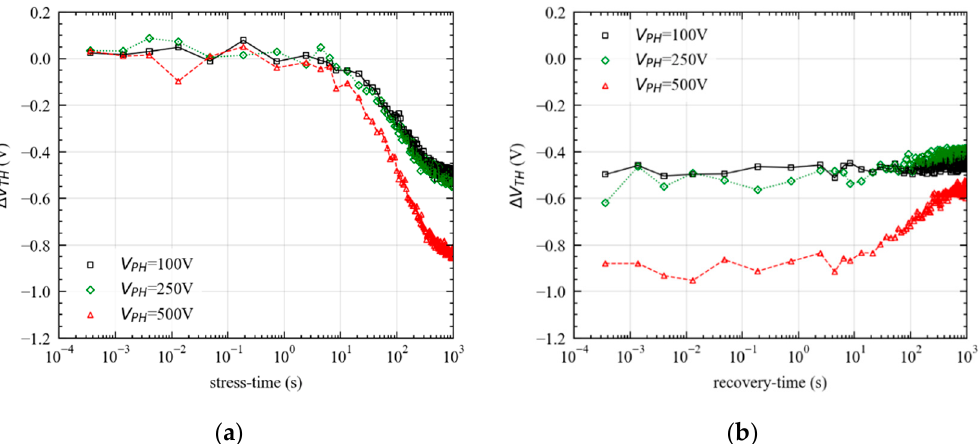
Figure 10. ( a ) Effect of drain off-state stress voltage (100 V, 250 V, and 500 V) on the V TH drift with V GH = 20 V. ( b ) Monitored V TH recovery after V PH removal ( V GH = 20 V).